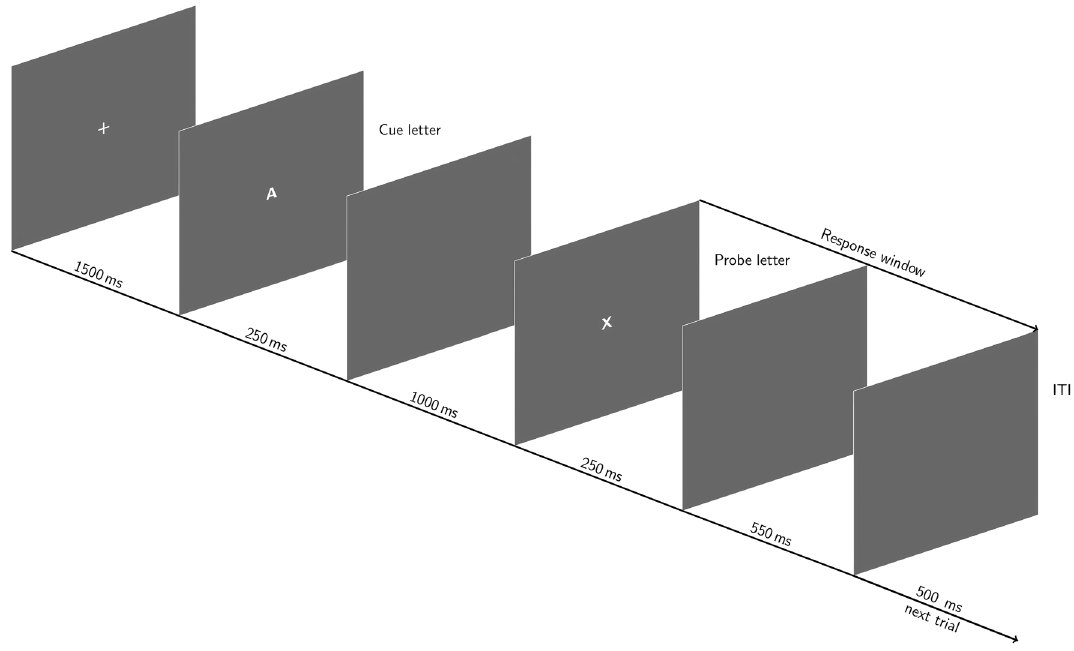
Figure 6. AX-CPT paradigm procedure used in the current study. The figure represents an "AX" trial, which appears in 70% of the trials, and that requires a right response for half the sample. The participant had 800 ms after the probe presentation to